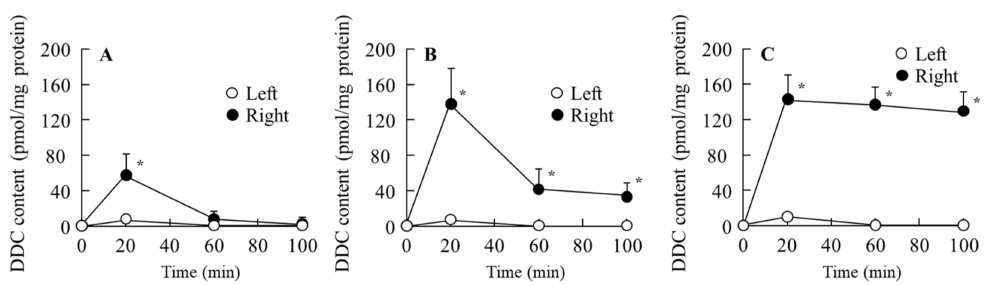
Figure 4. Changes in diethyldithiocarbamate (DDC) levels in the retinas of rats following the instillation of Dis-sol ( A ), Dis-NPs ( B ), and the Dis-NPs / ISG ( C ). The ophthalmic DIS formulations were instilled into the right eye of rats. The composition of the Dis-sol, the Dis-NPs, and the Dis-NPs / ISG is shown in Table 1. n = 4–8. * p < 0.05 vs. left for each category. Although DIS was not detected, the DDC was increased in the retinas instilled with DIS formulations. The DDC levels in the right retina were higher than those in the left retina in the used DIS formulations. Moreover, the DDC levels in the right retina of rats instilled with Dis-NPs were higher than those in the right retina of rats instilled with Dis-sol, and the retinal residence time of DDC was prolonged by the application of the in situ gelling